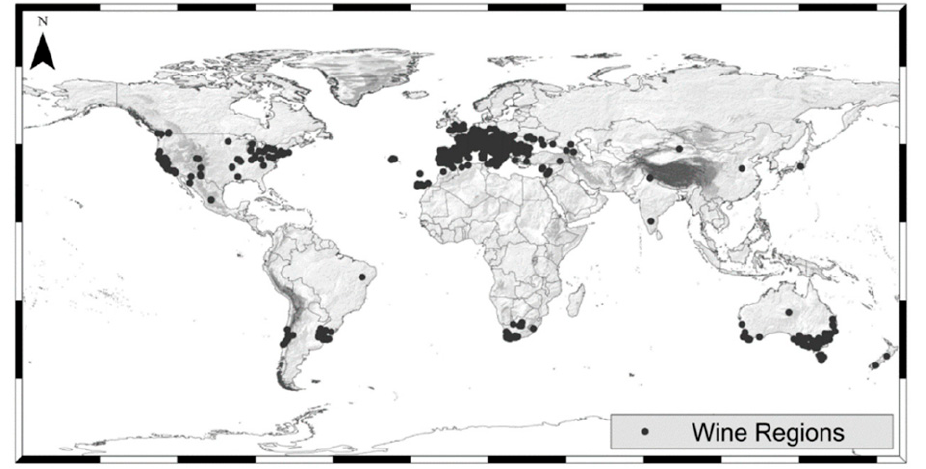
Figure 1. Distribution of wine-growing regions (circles) worldwide (Adapted with permission from ref. [16]. Copyright 2020 the authors).